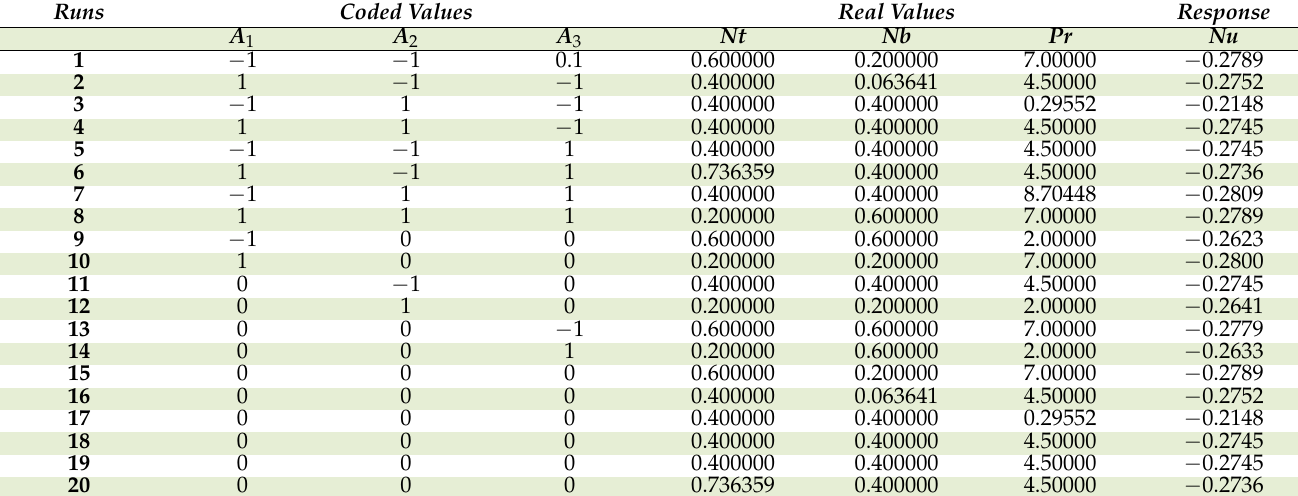
Table 8. Response via coded and real values of design parameters.